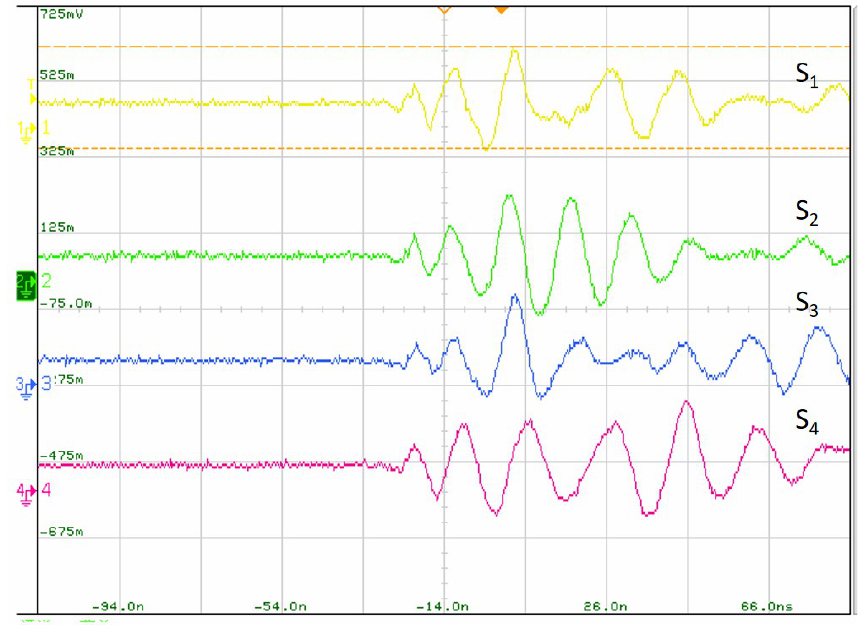
Figure 10. Actual PD